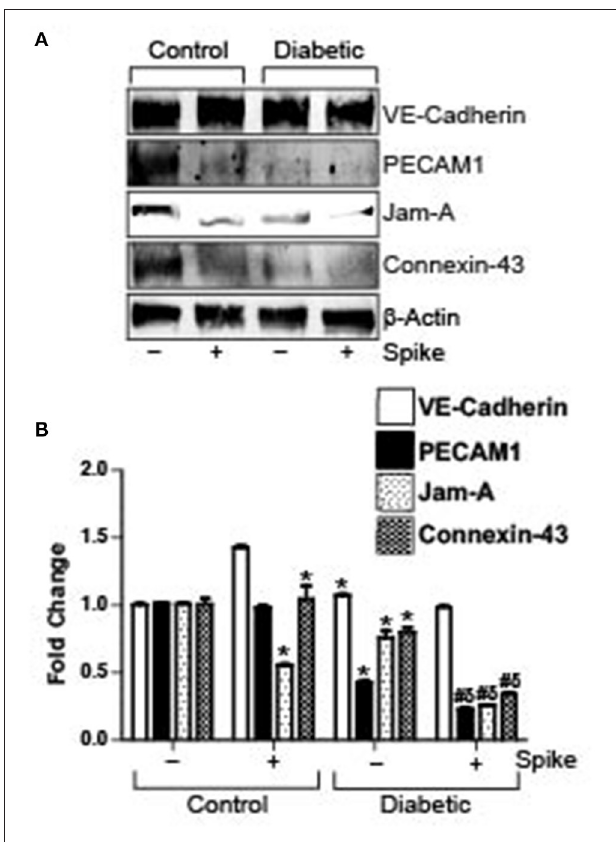
FIGURE 3 | Spike-induced degradation of endothelial junctional proteins is greater in arteries of diabetic mice. (A) Representative Western blot indicating expression of endothelial junctional proteins in arteries isolated from control or diabetic mice. (B) Mean data indicating fold change in protein expression. n = 4 for each, * P < 0.05 vs. untreated control, δ P < 0.05 vs. untreated diabetic, # P < 0.05 vs. Spike-treated